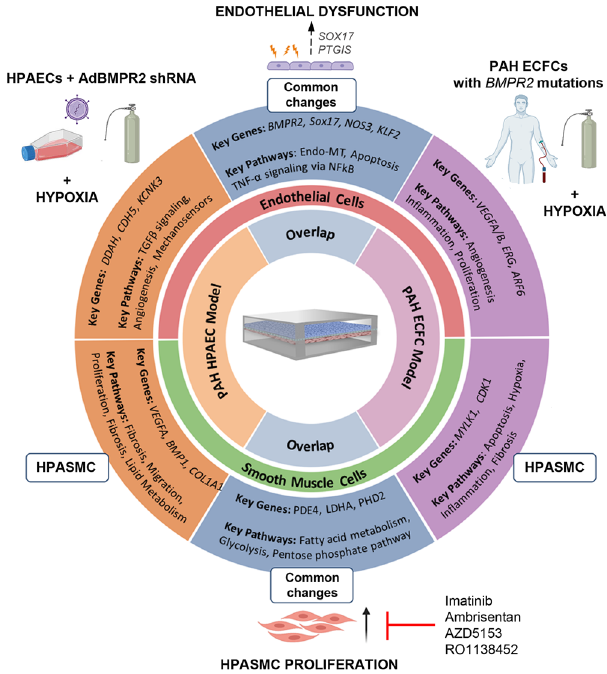
Fig. 8 Micro fl uidic two-hit model of PAH. AdBMPR2 shRNA-treated HPAECs and PAH ECFCs with disabling BMPR2 mutations were co-cultured with HPASMCs under hypoxic (2% O 2 ) conditions in PA-on-a-chip for 24 h. The diagram shows selected key PAH genes and pathways identi fi ed by transcriptomic pro fi ling of endothelial and smooth muscle